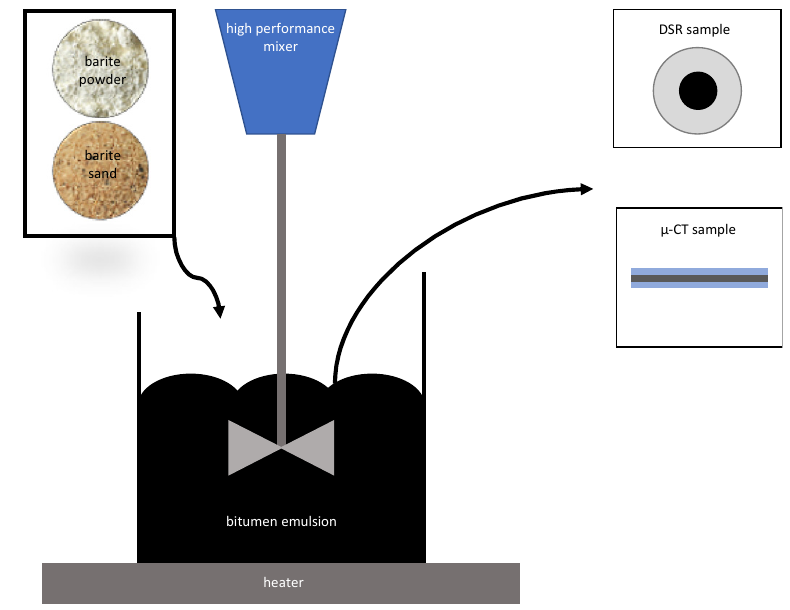
Figure 9. Particle size distribution of barite powder and barite sand.